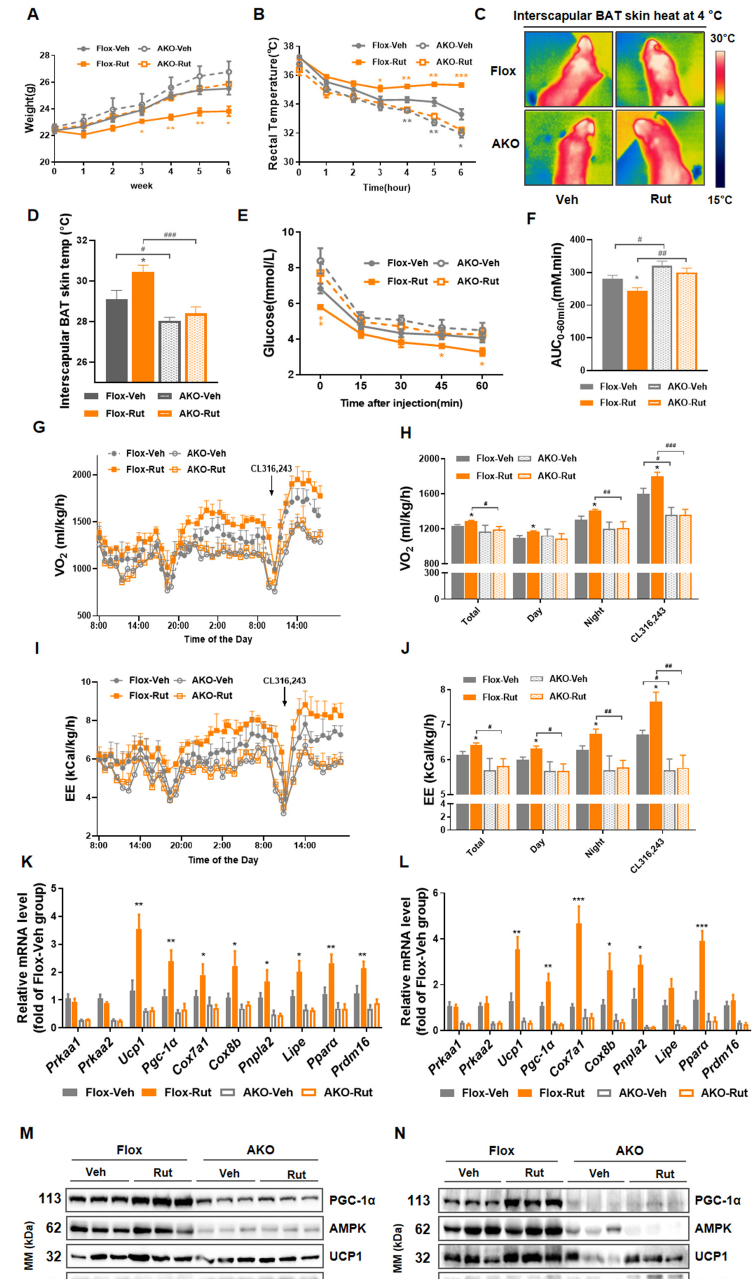
Figure 7. Thermogenic effects induced by Rut are attenuated by absence of AMPK. ( A ) Body weight of the indicated mice group. ( B ) Rectal temperature changes of four groups mice were recorded at 4 ◦ C. ( C ) Representative infrared thermal images of floxed or AKO mice treated with vehicle or Rut after 6 h of exposure to 4 ◦ C. ( D ) Statistical graphs of interscapular BAT skin heat. ( E ) Glucose levels were plotted versus times post insulin injection. ( F ) Analysis of AUC during ITT. ( G ) Testing of O 2 consumption. ( H ) Average of O 2 consumption under basal and CL316,243 stimulation conditions. ( I ) Assessment of EE. ( J ) Average of EE under basal and CL316,243 stimulation conditions. ( K , L ) Expression level of thermogenic genes by RT-qPCR analysis in iBAT ( K ) and iWAT ( L ). ( M , N ) Western blot analysis of AMPK, PGC-1 α and UCP1 expression level in iBAT ( M ) and iWAT ( N ) of different groups mice. n = 5–6 per group. Data are presented as the means ± SEM. Student’s t -test. * p < 0.05, ** p < 0.01, *** p < 0.001, Rut group versus vehicle group; # p < 0.05, ## p < 0.01, ### p < 0.001, AKO group versus floxed